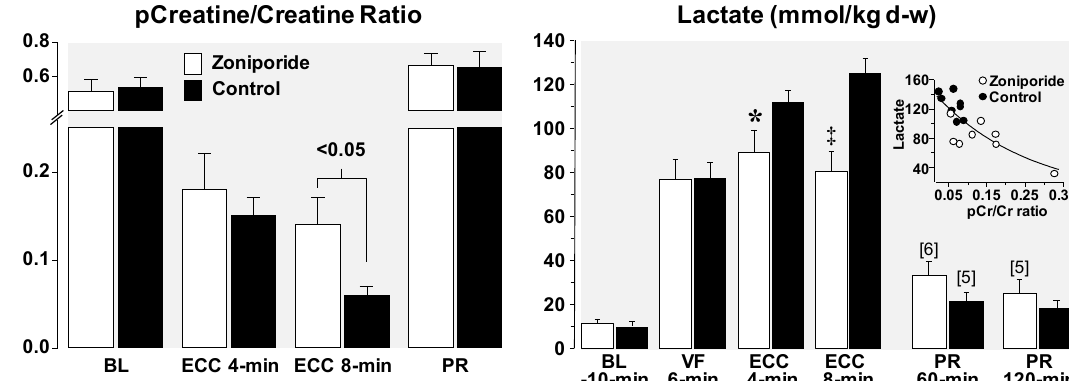
Figure 9. Myocardial measurements in pigs randomly assigned to receive 3 mg / kg of zoniporide or 0.9% NaCl control after 8 min of untreated ventricular fibrillation (VF) before starting extracorporeal circulation (ECC). Measurements were obtained at baseline (BL), during VF at ECC 4 and 8 min, and post-resuscitation (PR). Each group had eight pigs at baseline. Numbers in brackets indicate when sample size decreased from the initial eight or preceding ones. Shown are the ratio between myocardial phosphocreatine and creatine (pCr / Cr), myocardial lactate content, and (in the inset) the relationship between lactate and pCr / Cr ratio at ECC 8 min. The regression line represents an exponential decay function (R 2 = 0.63, p < 0.001). Mean ± SEM; * p < 0.05, ‡ p < 0.001 vs. control by Student’s t -test (adapted with permission from Ayoub et al. [6]).